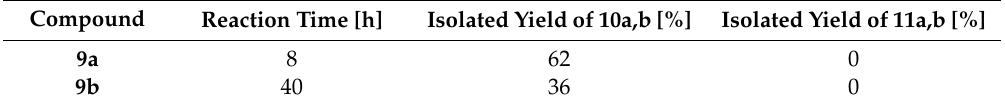
Table 5. Photocyclization of diimines 9a,b .